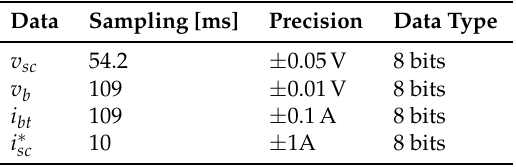
Table 2. CAN bus and data